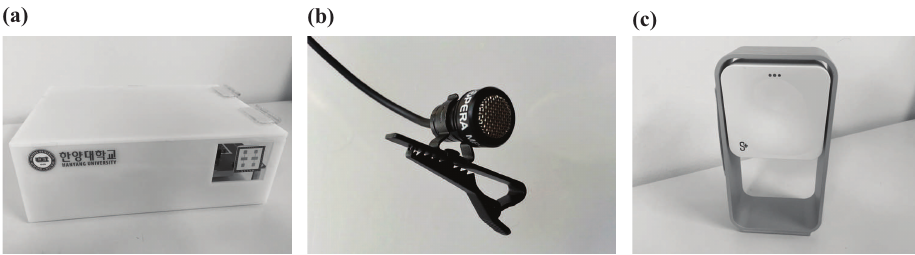
Figure 6. The devices used in experiment: ( a ) RFbeam K-LC5 Doppler radar sensor and ST-200 evaluation system; ( b ) OPERA MP-06 directional microphone sensor; ( c ) ResMed S+.